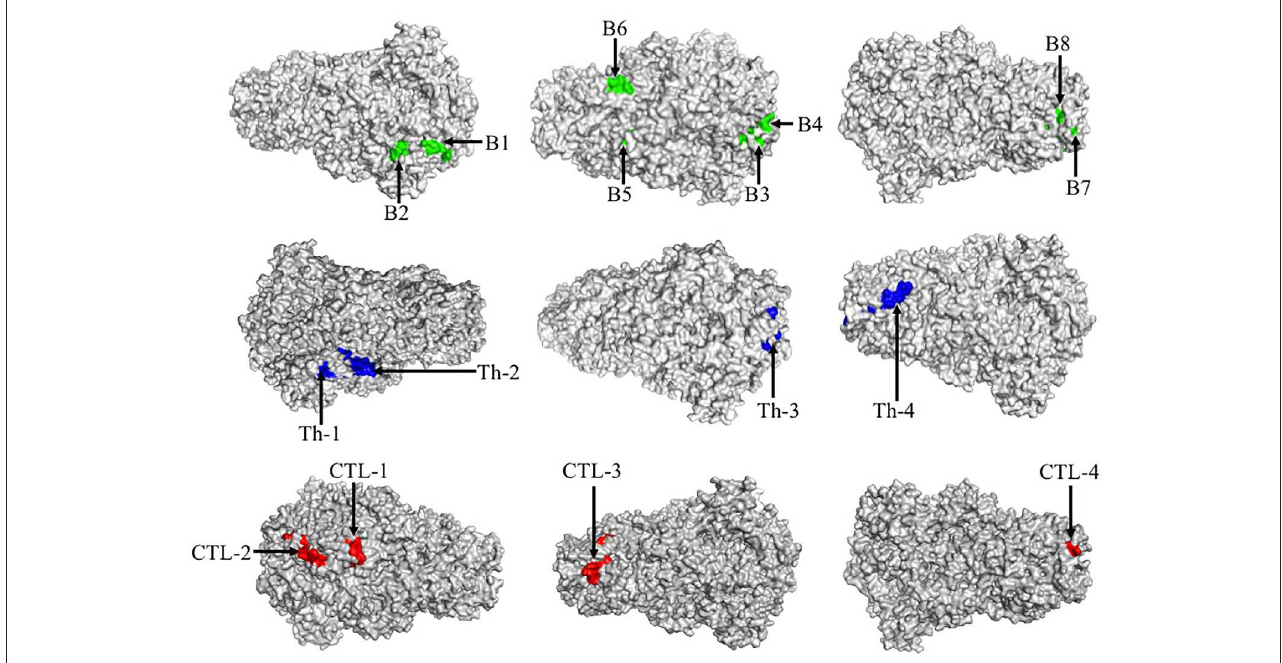
FIGURE3 Epitopes of SADS-CoV Spike protein candidate antigen. Tertiary structure of the spike protein with CTL epitopes marked by red color; HTL epitopes are marked by blue color and IFN- γ epitopes marked by green color; showing their surface positions.